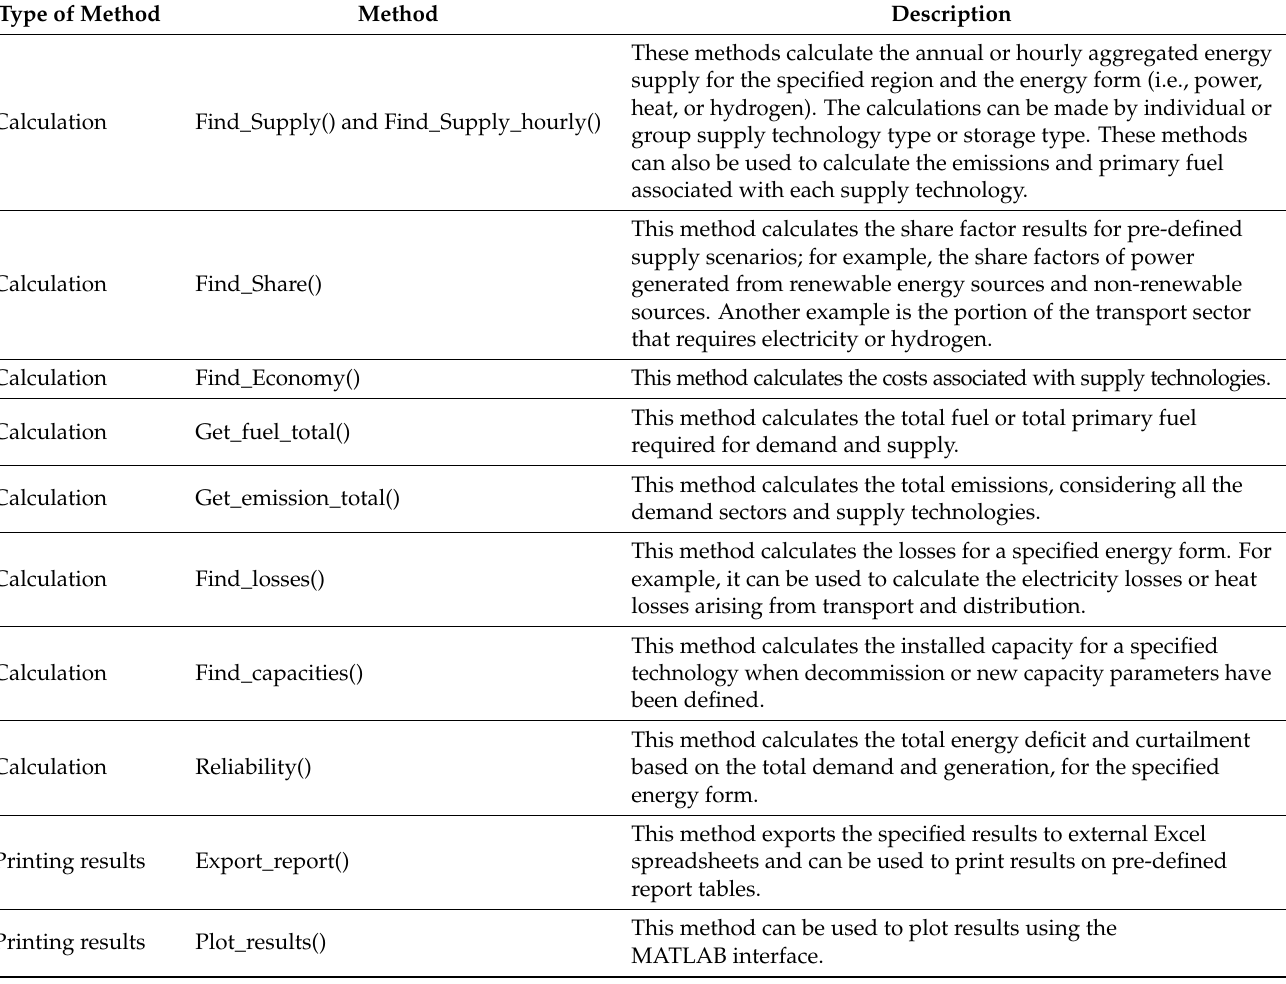
Table 15. Methods within the supply